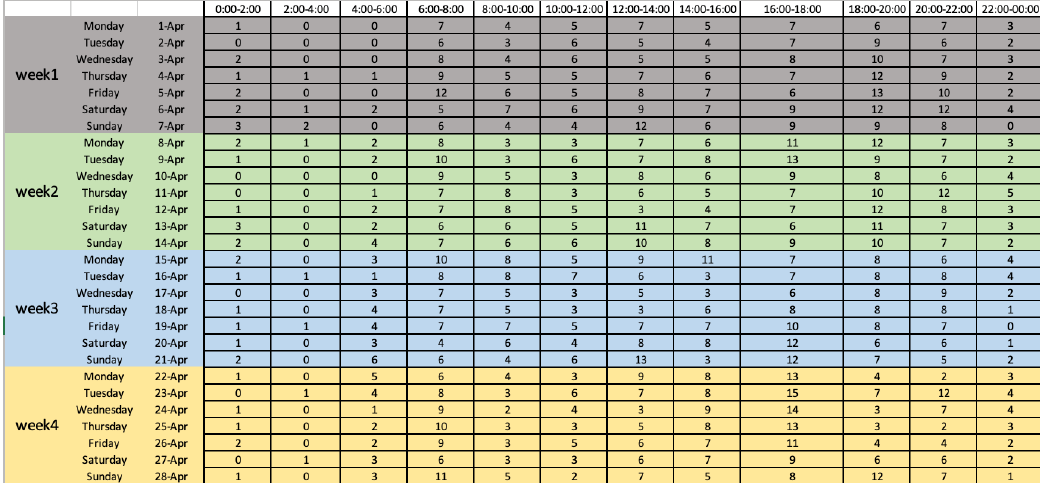
Figure 7 Data set for section2 (the value is number of